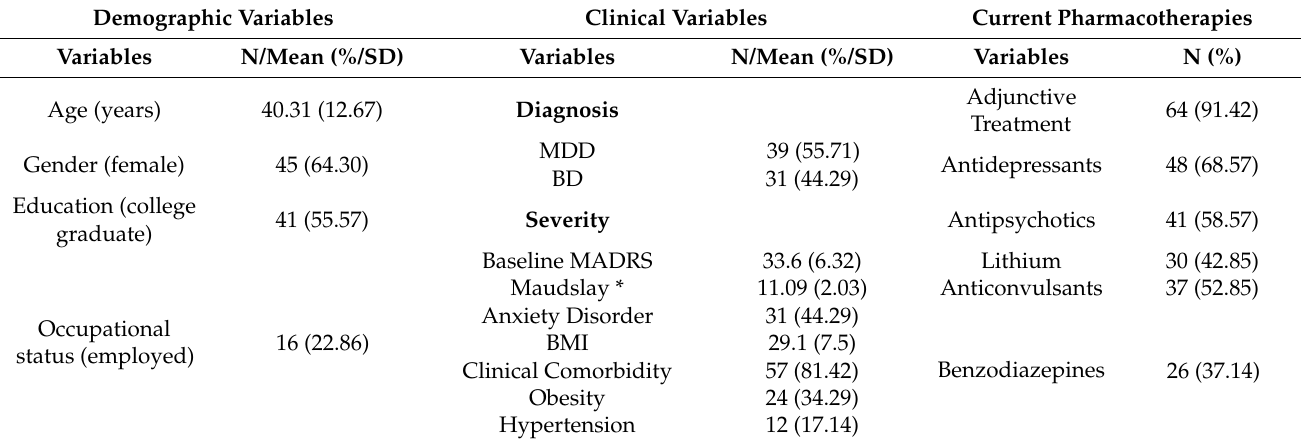
Table 1. Demographic and clinical characteristics of the